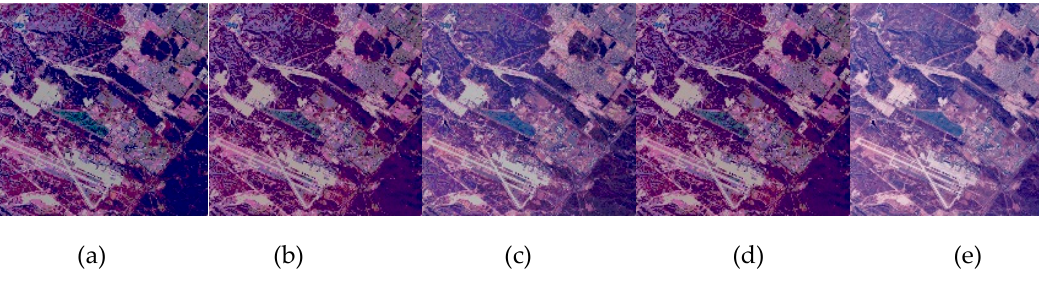
Remote Sens. 2019 , 11 , x FOR PEER REVIEW Figure 10. The segmented results of Satellite image3. ( a ) WOA; ( b ) FPA; ( c ) PSO; ( d ) BA; and ( e ) HSOA.